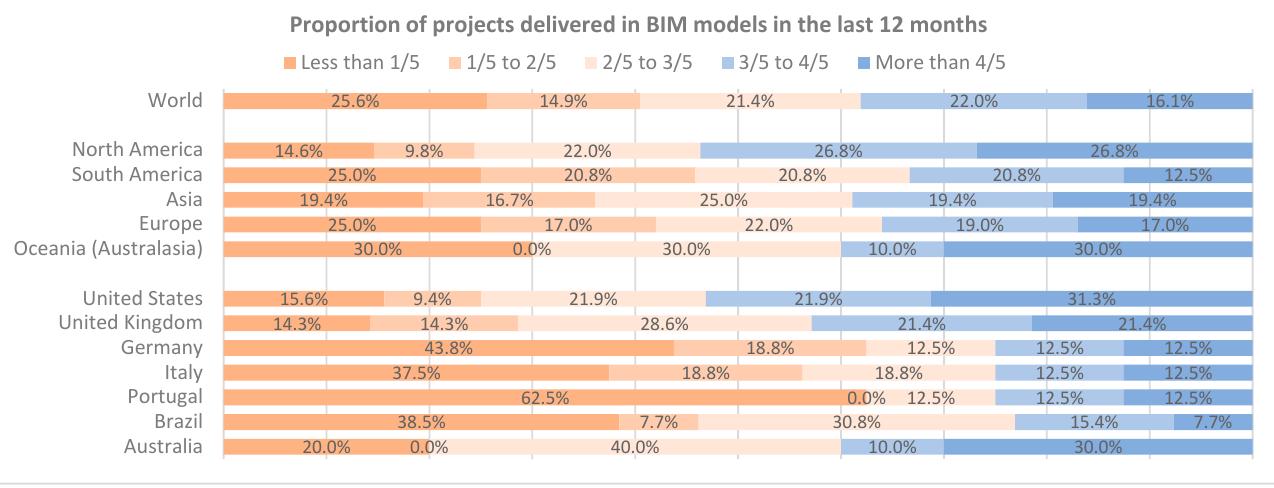
Figure 14. Proportion of projects delivered in BIM models in the last 12 months from surveys performed by terrestrial 3D laser scanning and digital photogrammetry.